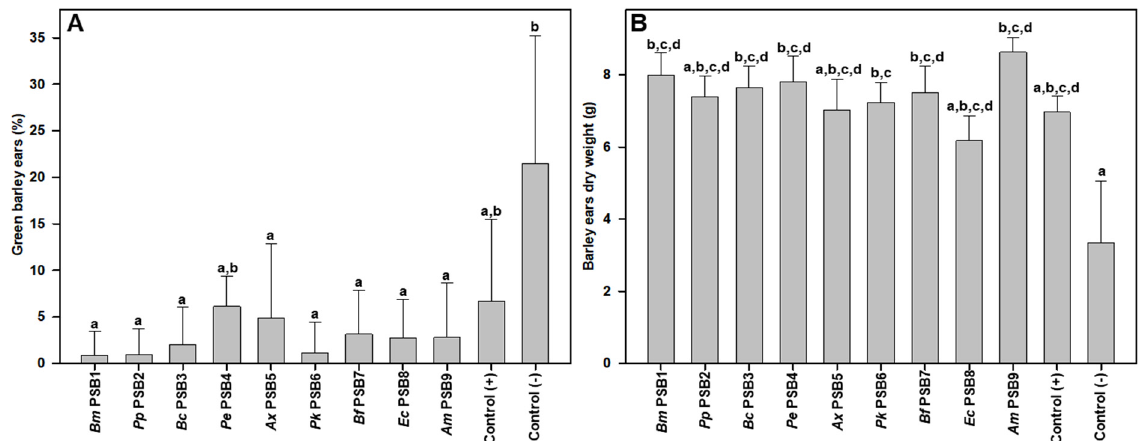
Figure 4. Maturation and development data of barley plant spikes inoculated with different PSB strains: percentage of immature, green barley ears at the end of the experiment ( A ) and dry weight of ears ( B ). The data shown correspond to the average of 9 replicates and each replica consisted of 10 plants sown per pot. Bars marked with the same letter are not significantly different ( p ≥ 0.05).